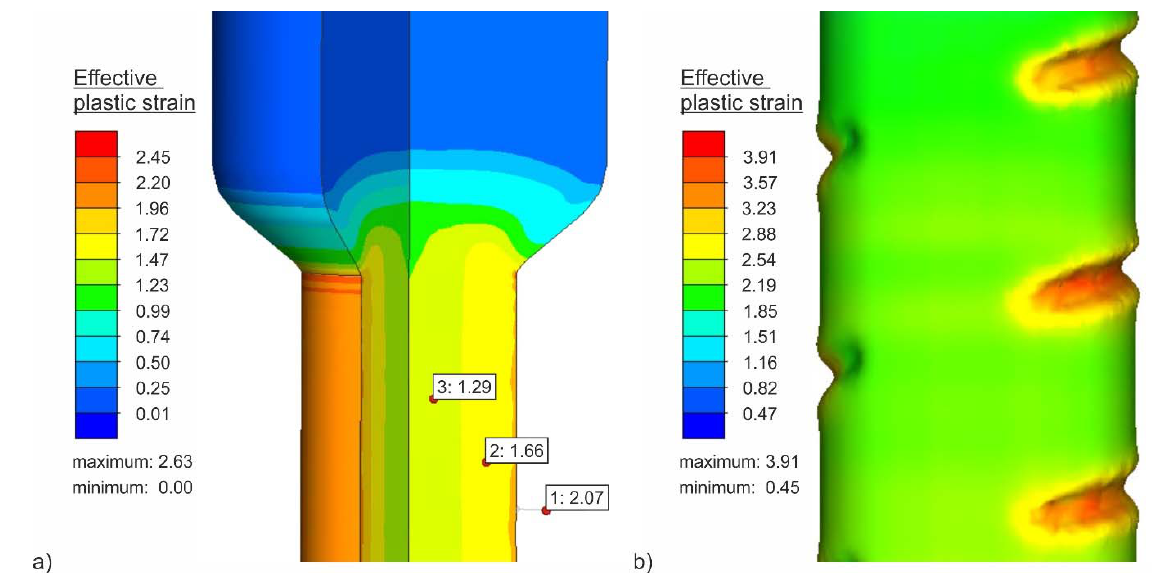
Figure 1. Finite element simulation of the ( a ) strain distribution after extrusion (70% area reduction) and ( b ) using these results for early stage thread rolling process. The strain introduced by extrusion is highest close to the outer surface and decreases with increasing distance to the surface.